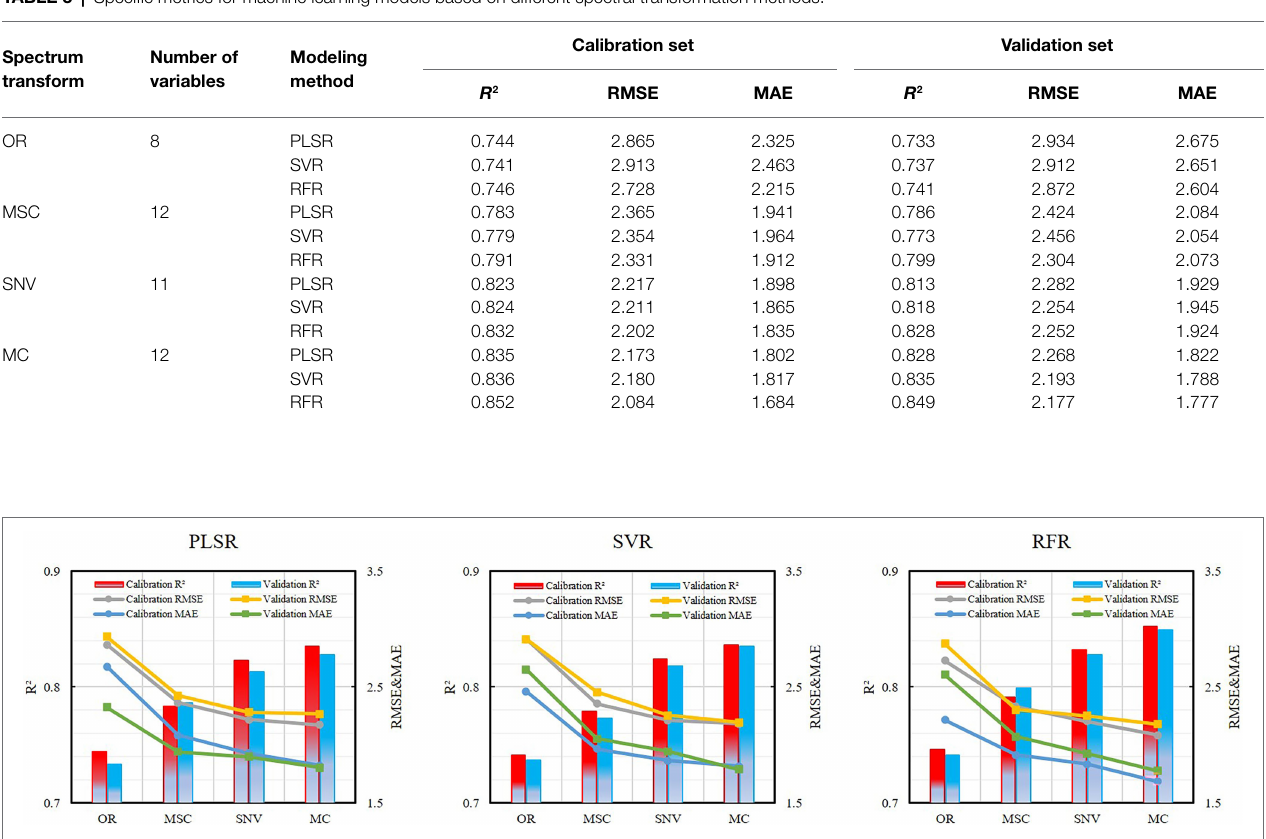
FIGURE 7 | Performance of spectral transformation data for the different models.